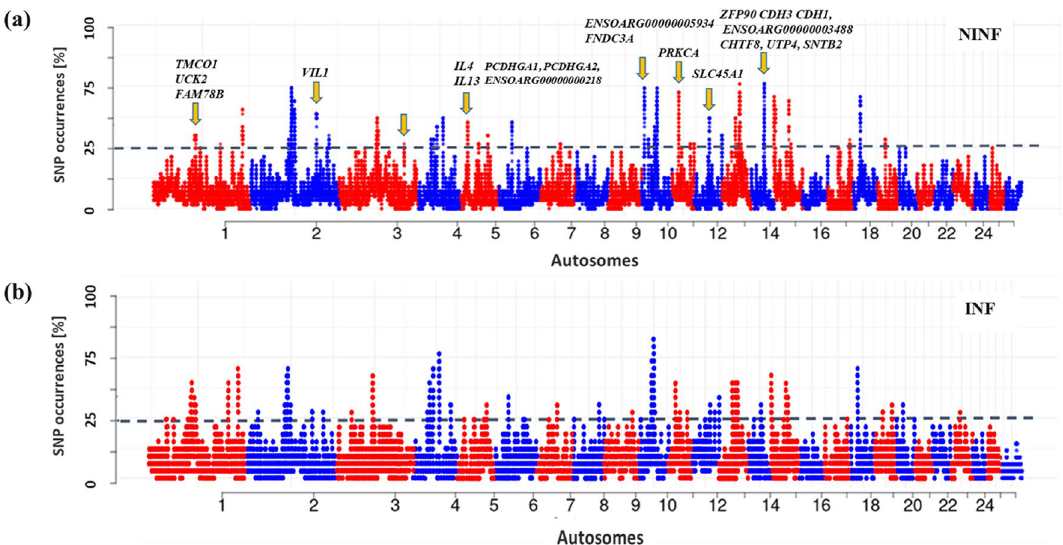
Figure 3. Manhattan plot showing genome-wide distribution frequency of SNPs in stretches of ROH regions. The dashed lines indicate the 25% threshold for each cohort. INF infected cohort; NINF non-infected